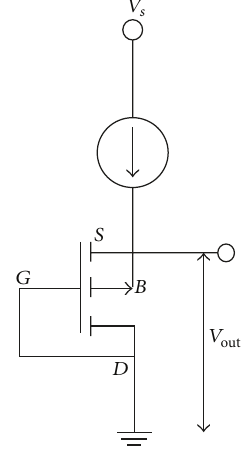
Figure 2: Electronic scheme for reader circuit